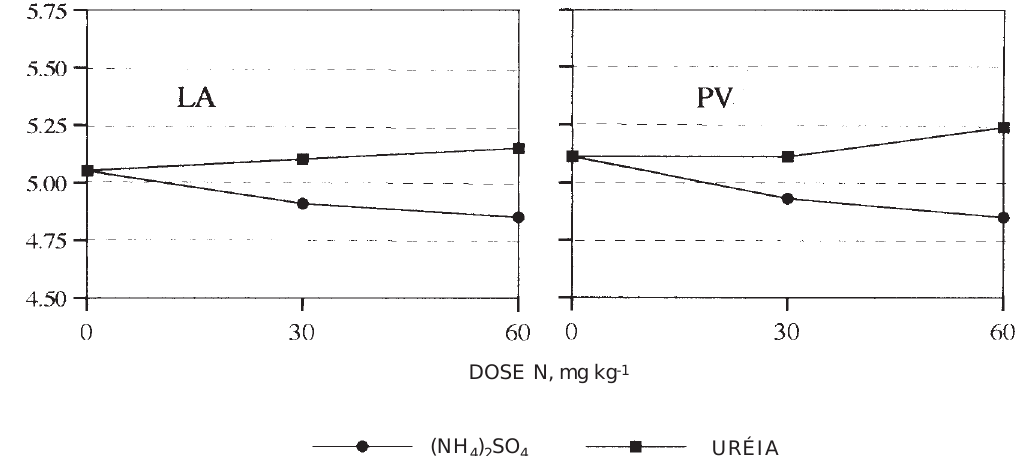
Figura 2. Variação do pH do solo sob efeito dos fertilizantes após o cultivo do "rye-grass" em dois solos da Amazônia Central